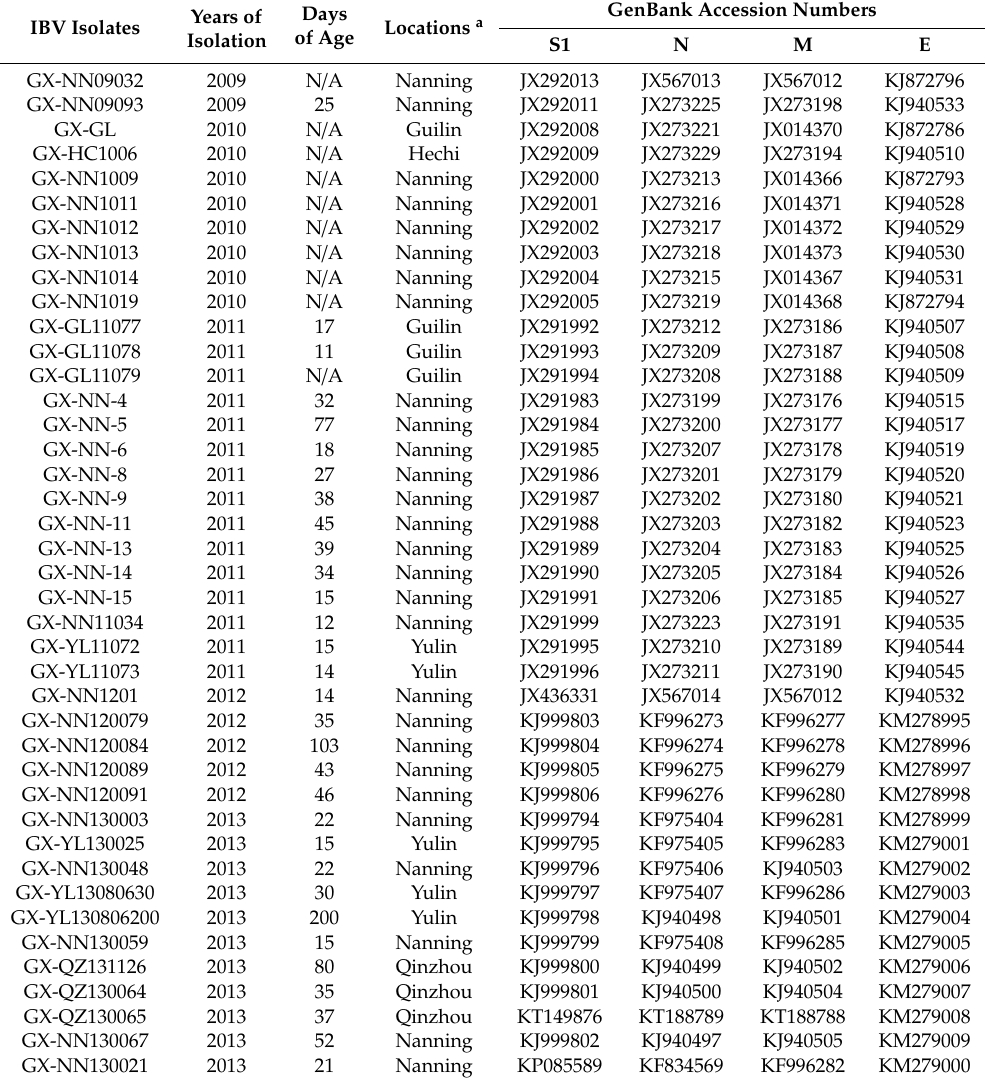
Table 1. Sixty-four IBV strains isolated during 2009–2017 in